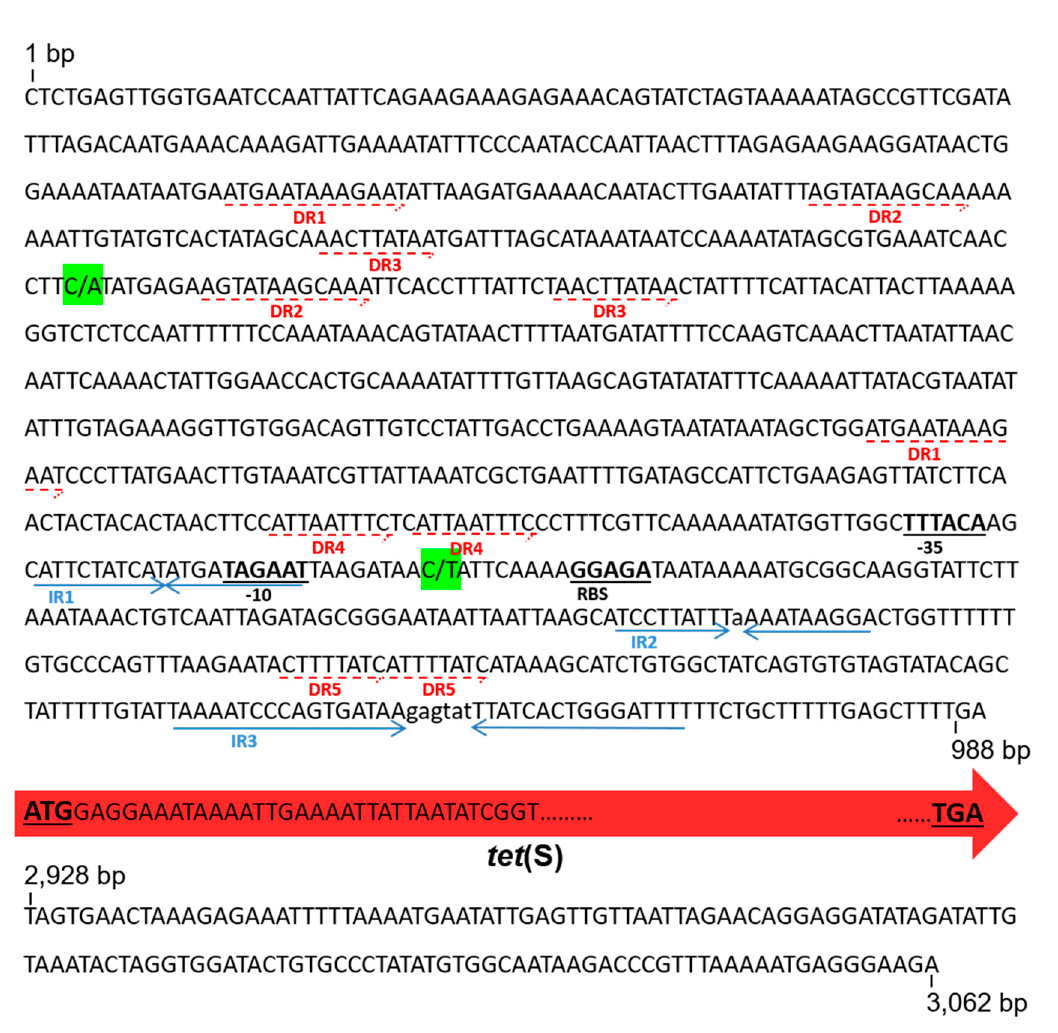
Figure 5. Conserved DNA sequence of the tet (S) gene and its surrounding regions in all resistance plasmids retrieved in L. lactis NZ9000. The red arrow represents the whole tet (S) gene from the start to the stop codons (in bold and underlined). Direct (DR) and inverted (IR) repeats upstream of tet (S) are underlined by solid pale-blue and dotted-red arrows, respectively. Putative -35 and -10 positions of promoter and ribosome binding site sequences are in bold and underlined. Colored in green, single nucleotide polymorphisms detected, respectively, in pTC1 (C → A) and pEMR1 (C → T).